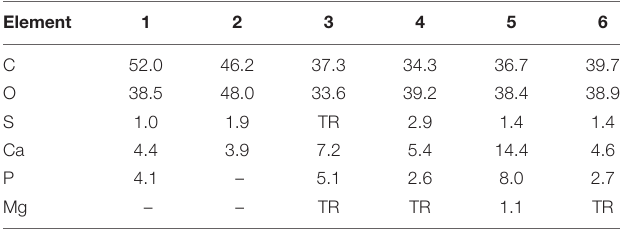
TABLE 3 | Energy dispersive X-ray spectroscopy analysis of exopolysaccharides.